Question: In one sentence, what is this figure communicating?
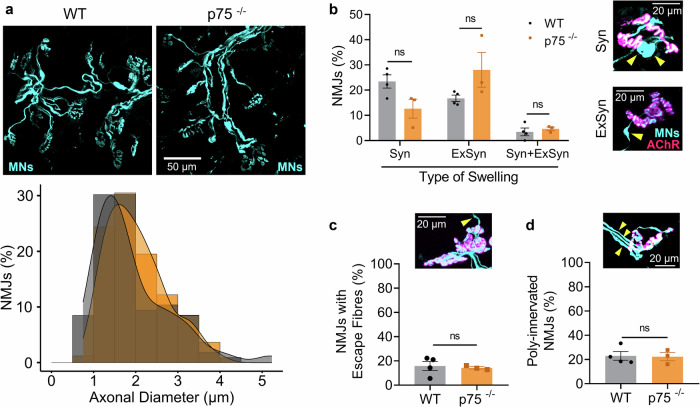
Answer: p75⁻/⁻ mice show no alterations in the presynaptic motor terminal of the NMJ during aging. Whole-mount lumbrical muscles from aged control and p75⁻/⁻ mice were immunostained to reveal motor axons and presynaptic terminals (2H3 + SV2 antibodies; cyan) and postsynaptic AChRs (BTX; magenta). a Upper panels show representative images of motor axon terminals from aged control and p75⁻/⁻ mice; the lower panel shows a histogram of axonal diameter distribution. Scale bar = 50 µm. b Quantification of the percentage of NMJs with presynaptic swelling in synaptic (Syn; arrowheads in top panel) or extrasynaptic (ExSyn; arrowhead in bottom panel) regions in aged control and p75⁻/⁻ mice. c Proportion of NMJs with escape fibres (arrowhead in image) in aged control and p75⁻/⁻ mice. d Percentage of poly-innervated NMJs (arrowheads in image) in aged control and p75⁻/⁻ mice. Scale bar = 20 µm ( b – d ). Data are shown as mean ± SEM (bars) and individual values (dots; N = 3–4 mice). Two-way ANOVA ( a , b ) and Mann-Whitney test ( c , d ). n.s. = non-significant.